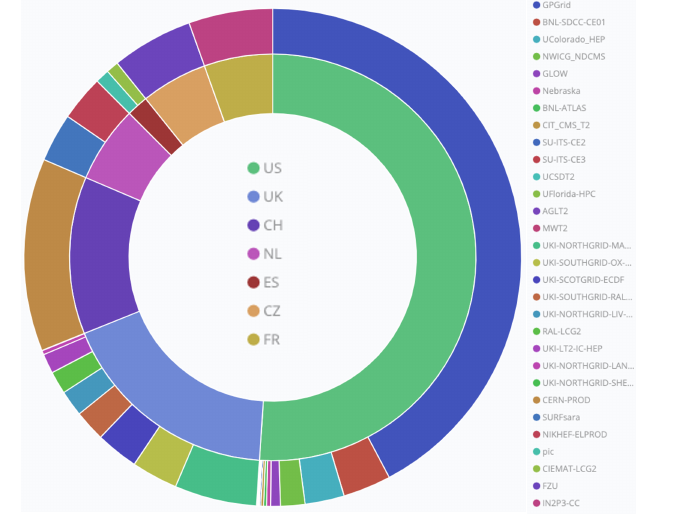
Figure 2. Wall time-weighted distribution of successful DUNE Production jobs January 2019 to November 2019. Inner ring: distribution by country. Outer ring: distribution by site. Sites outside the United States delivered 49% of the total wall hours for the jobs shown